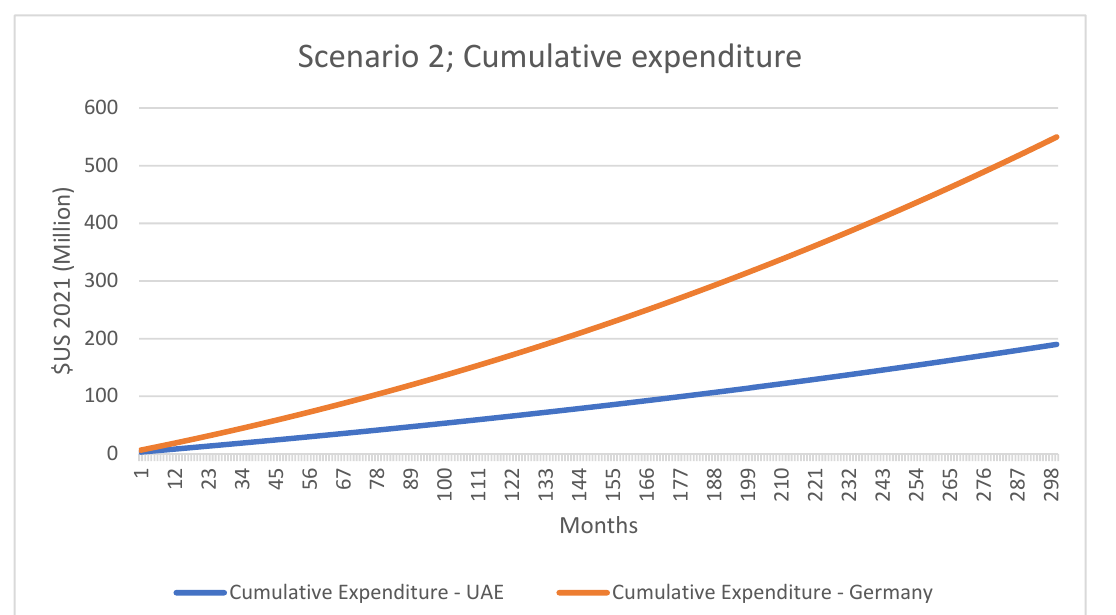
Figure 9. Cumulative emissions through electricity consumption for UAE and DE under scenario 2.